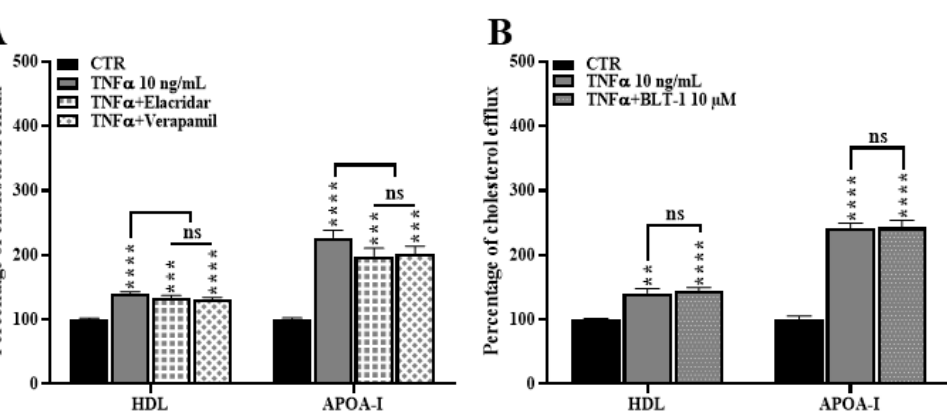
Figure 8. SR-BI and ABCB1 are not involved in TNF α mediated cholesterol efflux from HBP. After 48 h of incubation with TNF α (10 ng/mL), cholesterol efflux to lipid acceptors HDL (50 µ g/mL) and APOA-I (20 µ g/mL) was assessed during 8 h in the presence or absence of elacridar (10 µ M) or verapamil (50 µ M) to inhibit ABCB1 ( A ) or BLT-1 (10 µ M) to inhibit SR-BI ( B ). Each bar represents the mean ± SEM of two independent experiments within four replicates each (N = 2; n = 8). Control condition (CTR) was only treated with vehicle. Statistical analysis: one-way ANOVA followed by Tukey’s multiple comp arison (for equal variances) and one-way ANOVA Welsh test followed by Games- Howell’s multiple comparison (for significantly different variances) ns: non -significant, ** p < 0.01, *** p < 0.001, **** p < 0.0001.